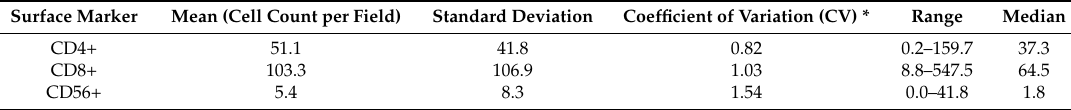
Table 4. Infiltration of T cell subtypes in 44 MPM cases